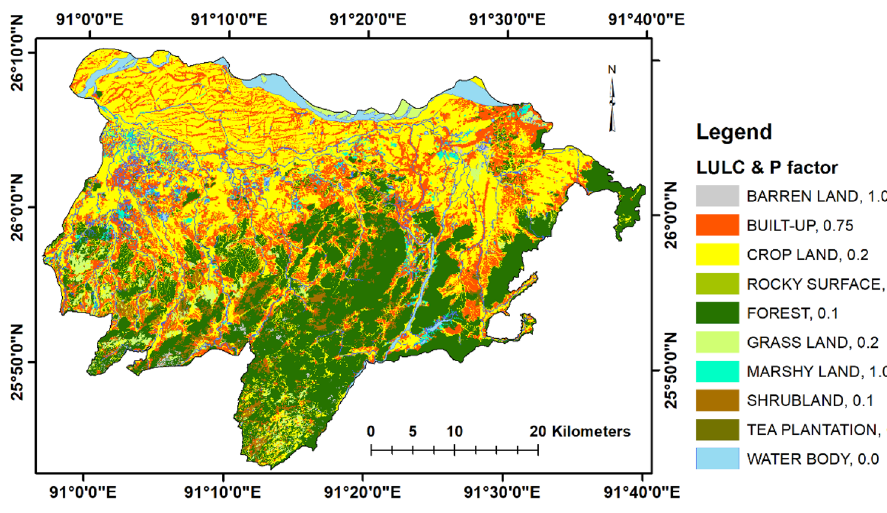
Fig. 6 Land use and land cover map and corresponding sup- port practice factor